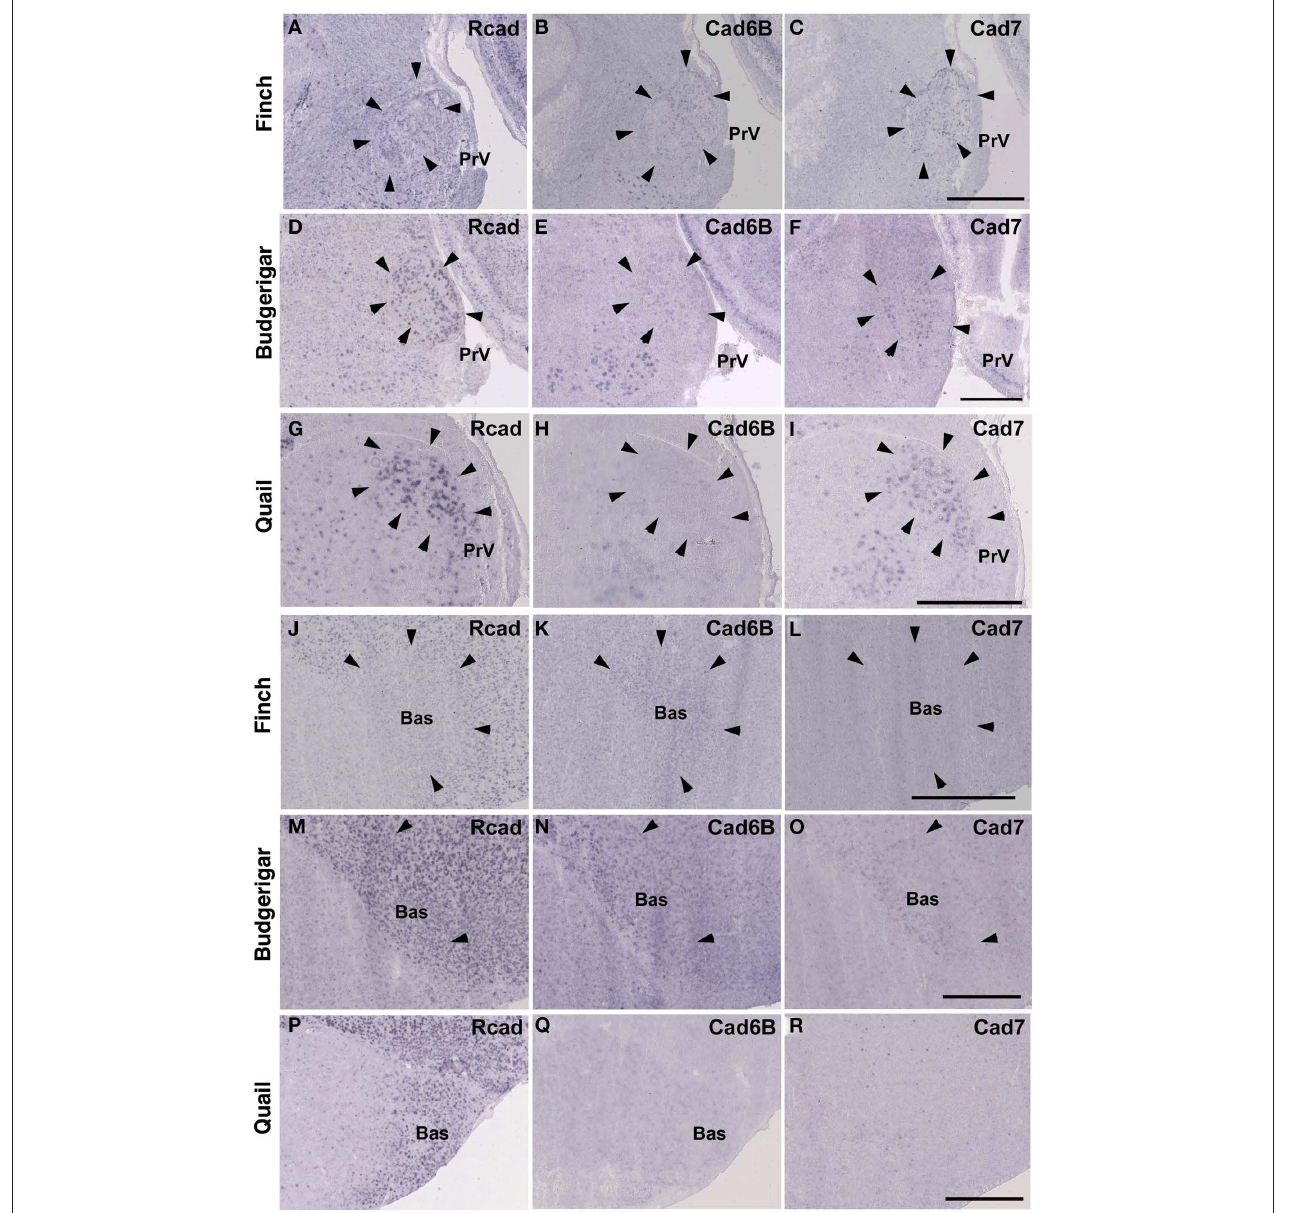
Figure 9 | Cadherin expression in the trigeminal pathway. (A–i) In situ hybridization for Rcad (A,D,g) , cad6B (B,e,H) , and cad7 (C,F,i) in the Bengalese finch (A–C) , budgerigar (D–F) , and quail (g–i) in the principal sensory nucleus of